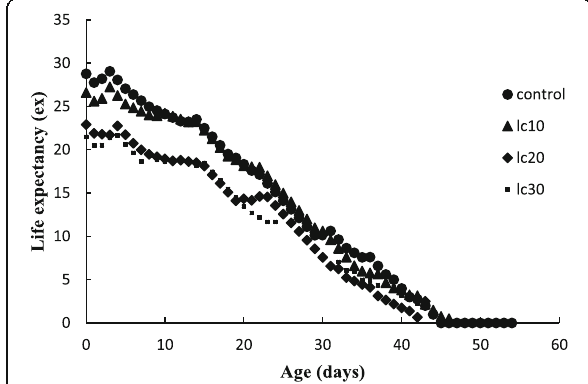
Fig. 1 Life expectancy ( e x ) of Tuta absoluta treated with different sub-lethal concentrations of Metarhizium anisopliae (DEMI 001